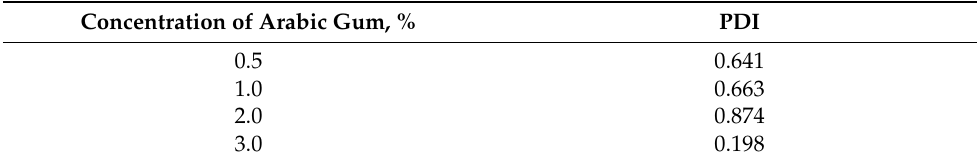
Table 2. PDI coefficient for nanoparticles obtained using different concentrations of gum